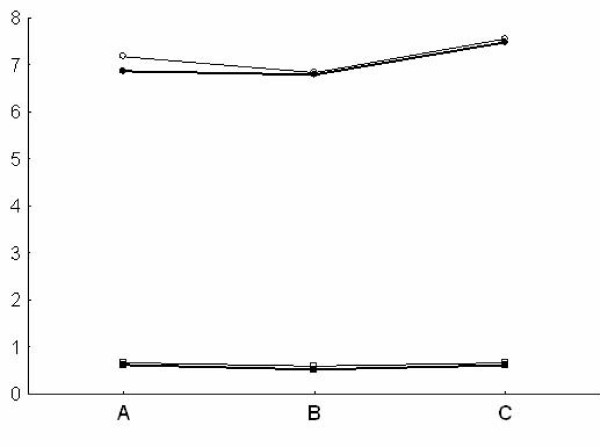
Basilar Artery: Mean of Depth (circle) and Pulsatility index (square) in TCD (narrow line) and TCCS (thick line) in the three groups of patients A, B, C.